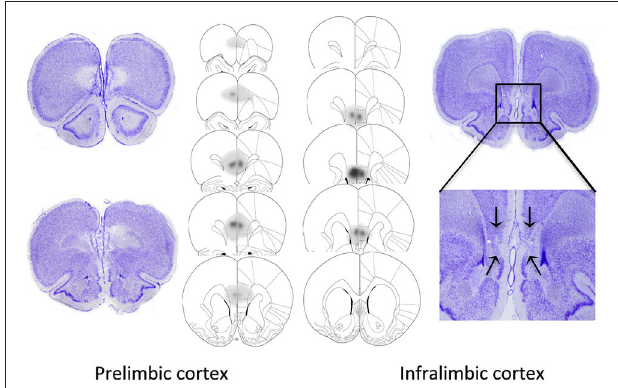
FIGURE 2 | Representative photomicrographs and extent of quinolinic lesions of the PL cortex (left) and IL cortex (right) . Photomicrographs show cresyl violet-stained coronal sections of rat brains with selective PL, or IL lesions. PL lesions were typically marked by a complete loss of cell bodies in the PL area and preservation of neurons in the IL region. IL lesions typically induced marked shrinkage of surrounding tissue, while preserving the PL region. The schematic diagrams denote the largest (dark gray), and smallest (light gray) extent of neuronal damage in the PL and IL lesioned animals.